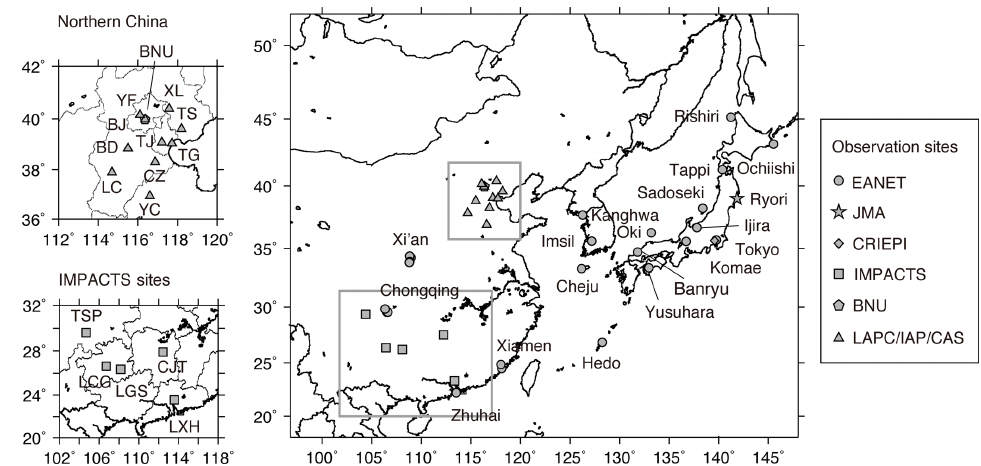
Figure 1. Geographical mapping of observation sites included in this study. Detailed information about each observation site is provided